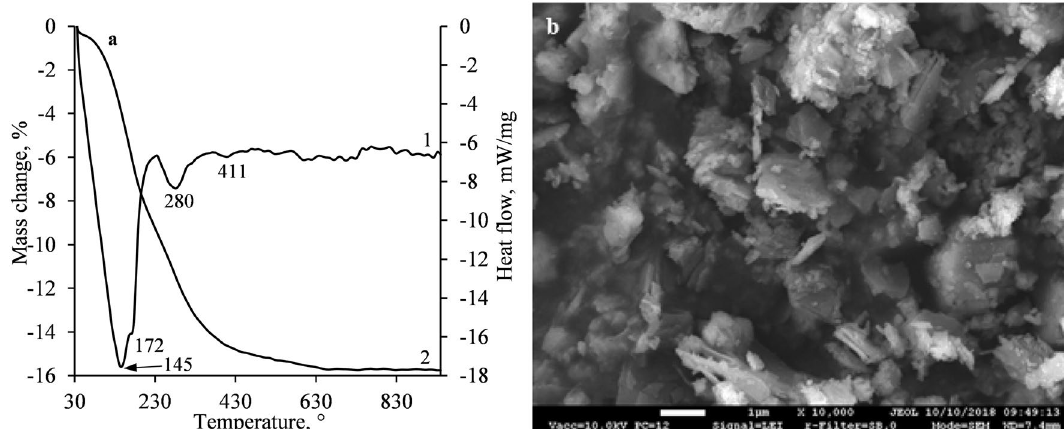
Figure 8. STA ( a ) curves (1-DSC; 2-TGA) and SEM micrographs ( b ) of S1-1100 sample after 24 h of